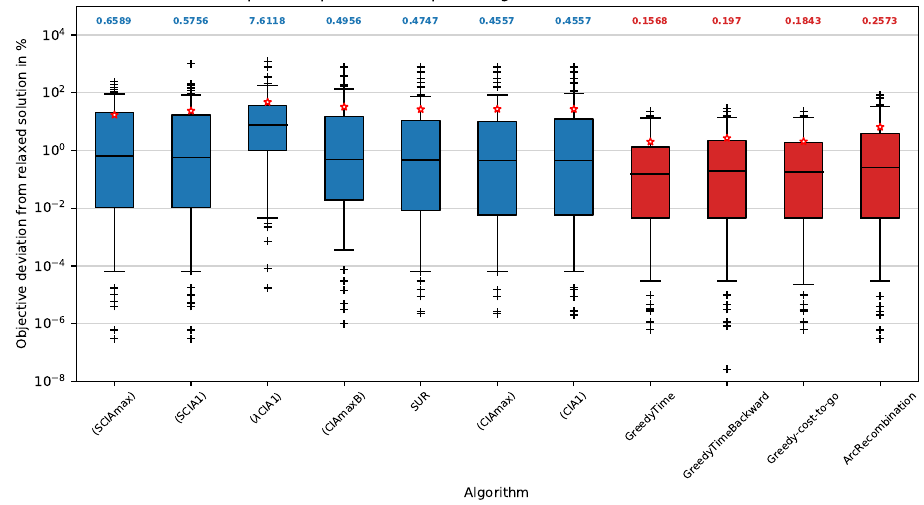
Figure 6. Box plot comparing objective deviation from the relaxed solution in percentage and log- scale of several MILP (marked in blue) and recombination heuristic (marked in red) solutions. The results are based on instances from the mintoc.de benchmark library. The box borders are 1/4 and 3/4-quantiles, whereas the whiskers represent 1/20 and 19/20-quantiles. We visualize the median values by black lines in the box and additionally display them numerically above the box. We represent the average values of the respective algorithms by red asterisks and the outliers by black crosses. The boxes of recombination strategies are shifted towards lower objective values compared with (CIA) algorithms and, thus, can improve the CIA decomposition performance